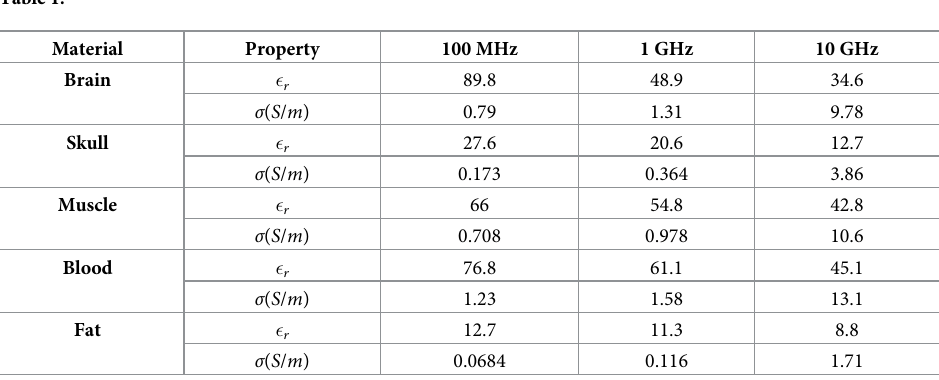
Table 1. Material Property 100